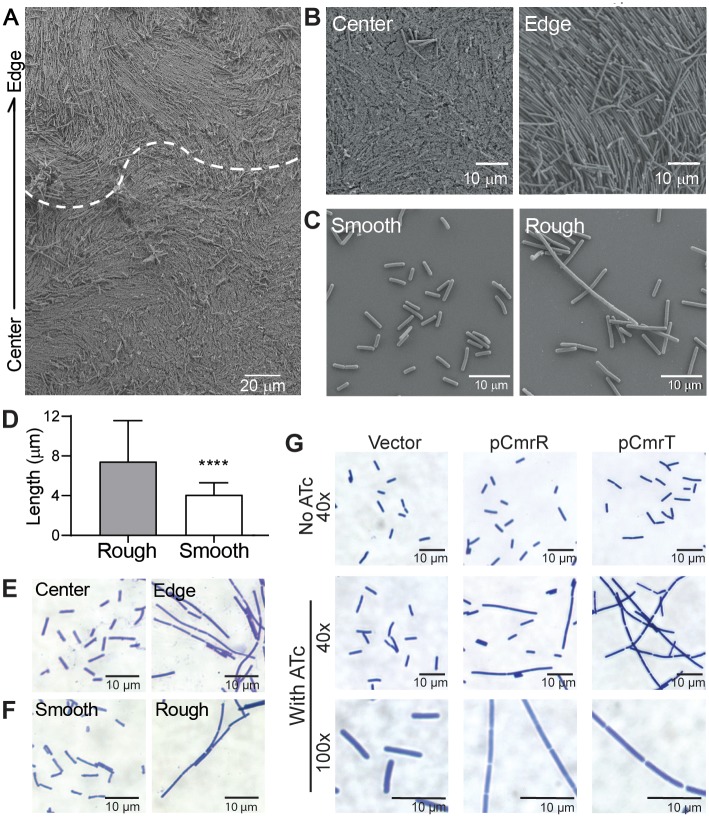
CmrR and CmrT promote bacterial chaining.(A) SEM images of a whole R20291 colony after 3 days of growth on BHIS agar. (A) A colony excised on an agar slice at 1 × 103 magnification. The arrow denotes the orientation of the image with respect to the colony. The dotted line marks the apparent transition from the colony edge and center. (B) Shown are 2.5 × 103 magnification images of cells at the colony center and edge. (C) Shown are 4.5 x 103 magnification images of rough and smooth cell suspensions. Samples were grown in broth culture prior to fixation. Shown are representative images from two biological replicates. (D) Quantification of cell lengths obtained from SEM images using ImageJ. Cells were measured from at least seven images from two biological replicates (rough n = 574, smooth n = 457). ****p < 0.0001 by unpaired t test. Data can be found in supplemental file S1 Data. (E, F) Gram stain of C. difficile samples taken directly from the center and edge of a colony (E) or from rough and smooth colonies (F) at ×60 magnification. G) Gram stain of C. difficile with plasmids for expression of cmrR or cmrT, or a vector control were grown on BHIS agar with and without inducer (10 ng/mL ATc for vector and pCmrR; 2 ng/mL ATc for pCmrT). Magnifications are indicated. Shown are representative images from two independent experiments. ATc, anhydrotetracycline; BHIS, brain heart infusion plus yeast; cmr, colony morphology regulators; SEM, scanning electron microscopy.